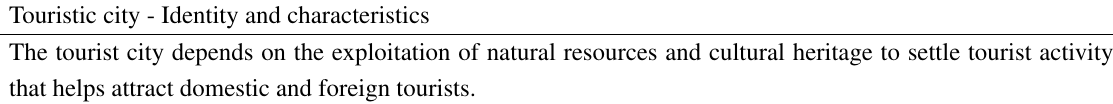
Table 6. Touristic city - Identity and characteristics